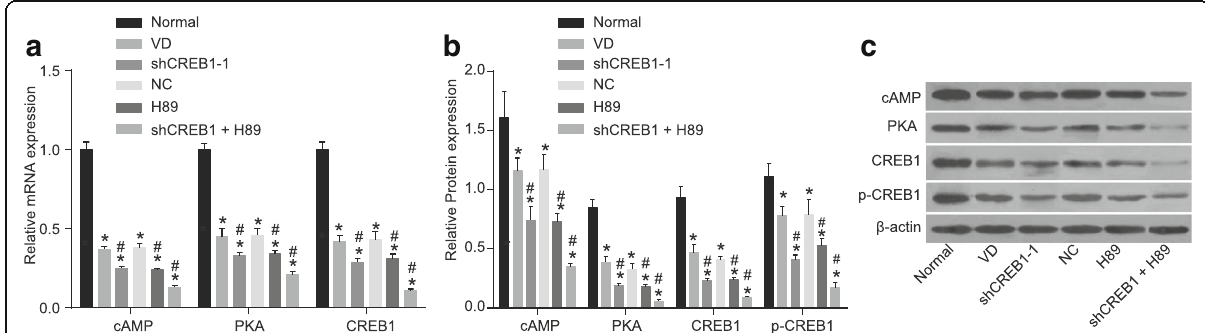
Fig. 7 Decreased expression of cAMP, PKA, CREB1 and p-CREB1 in hippocampal tissues of mice with shCREB1 – 1 or/and H89, Notes: A, the histo- gram of the mRNA expressions of cAMP, PKA and CREB1 in hippocampal tissues of mice in each group; B, The histogram of the expressions of cAMP, PKA and CREB1 in hippocampal tissues of mice in each group; C, Gray value of cAMP, PKA and CREB1 protein bands; * , p < 0.05, compared with the normal group; # , p < 0.05, compared with the VD group; cAMP, cyclic adenosine monophosphate; PKA, protein kinase A; CREB1, cyclic adenosine monophosphate responsive element-binding protein 1; VD, vascular